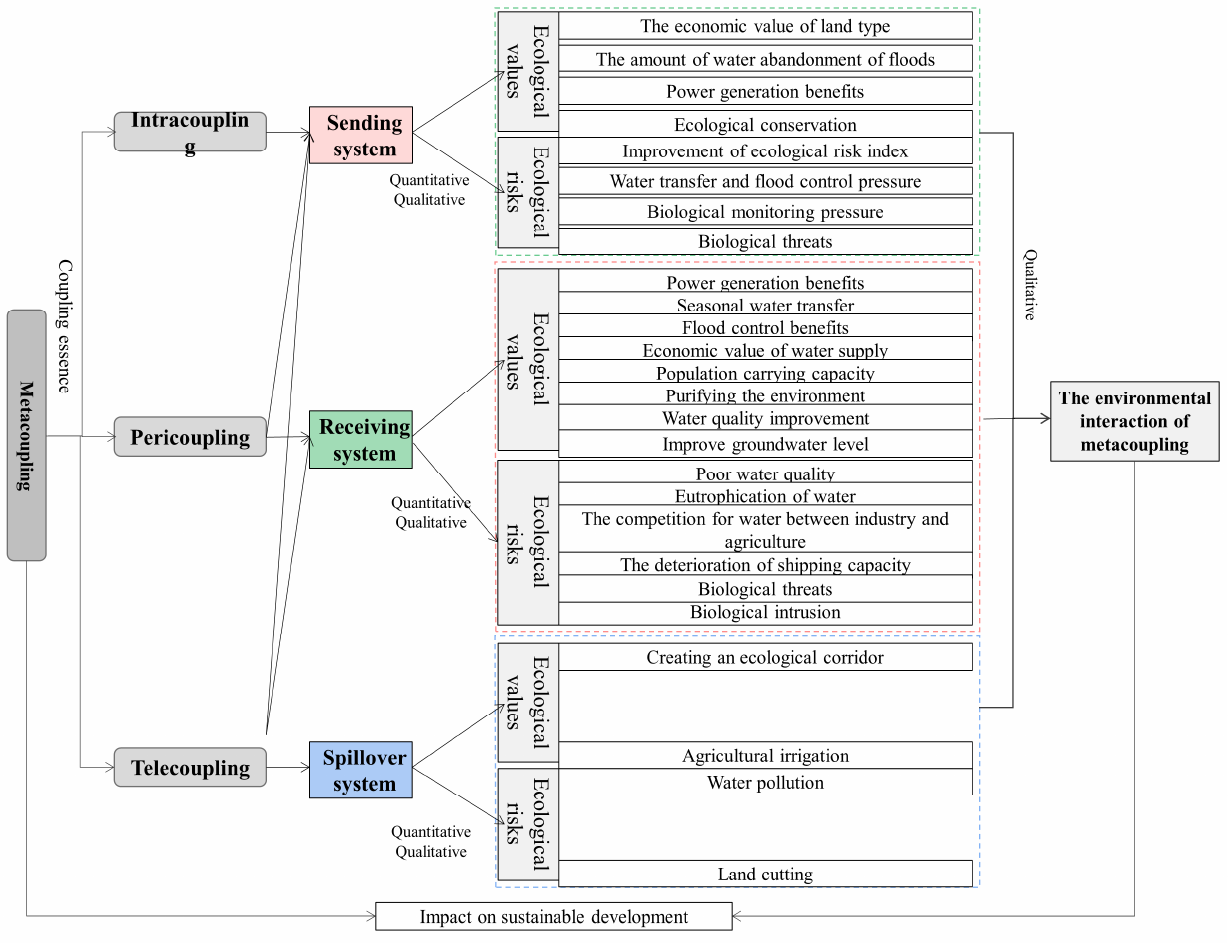
Figure 3. Research framework of SNWTP ‐ MR metacoupling.